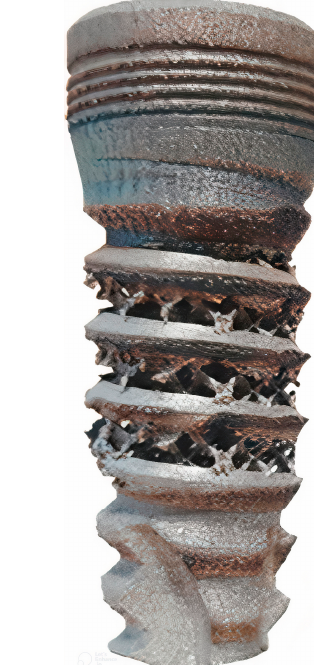
Figure 5. ( A ) Dental implant exterior with the barrette deployed. ( B ) X-ray image once inserted inside a cadaveric human osteoporotic jaw. inside a cadaveric human osteoporotic jaw.